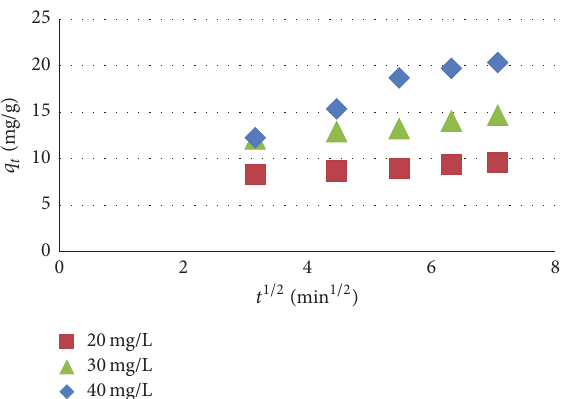
Figure 15: Intraparticle diffusion plot for adsorption of MB on DNPH- 𝛾 -alumina nanoparticles at different initial concentrations.